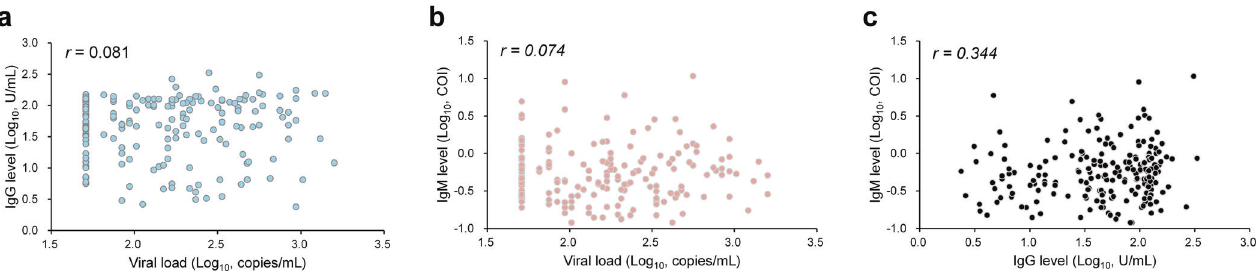
Fig. 4 The scatter plots among the IgG and IgM titers and viral loads based on N gene in the asymptomatic individuals with SARS-CoV-2 infection. a The correlation between IgG level and viral loads; b The correlation between IgM level and viral loads; c The correlation between IgG level and IgM level. The correlation coef fi cient was calculated by Spearman rank correlation